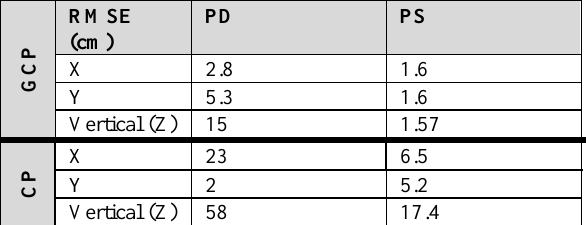
Table 4. RMSE in cm for the ground control and check